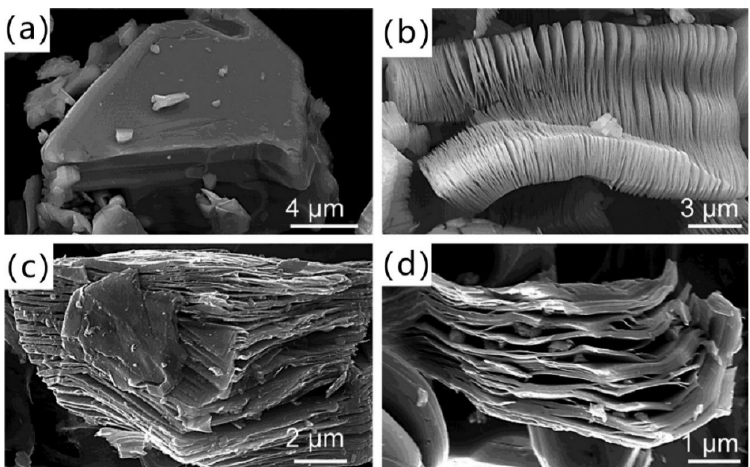
Fig. 10 SEM micrographs for (a) Ti 3 AlC 2 particle, a typical MAX phase, (b) Ti 3 C 2 MXene made by HF etching from Ti 3 AlC 2 , (c) Ti 2 C MXene, and (d) Ta 4 C 3 MXene. Reproduced with permission from Ref. [8], © American Chemical Society 2012.